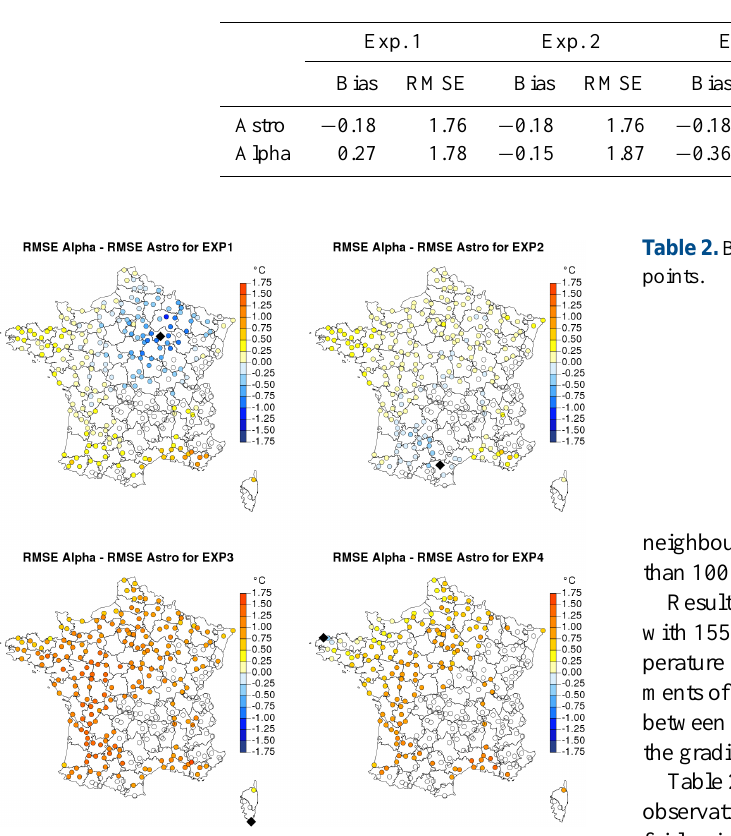
Table 1. Bias and RMSE of pseudo-observation for the four extreme experiments for astro and alpha methods.